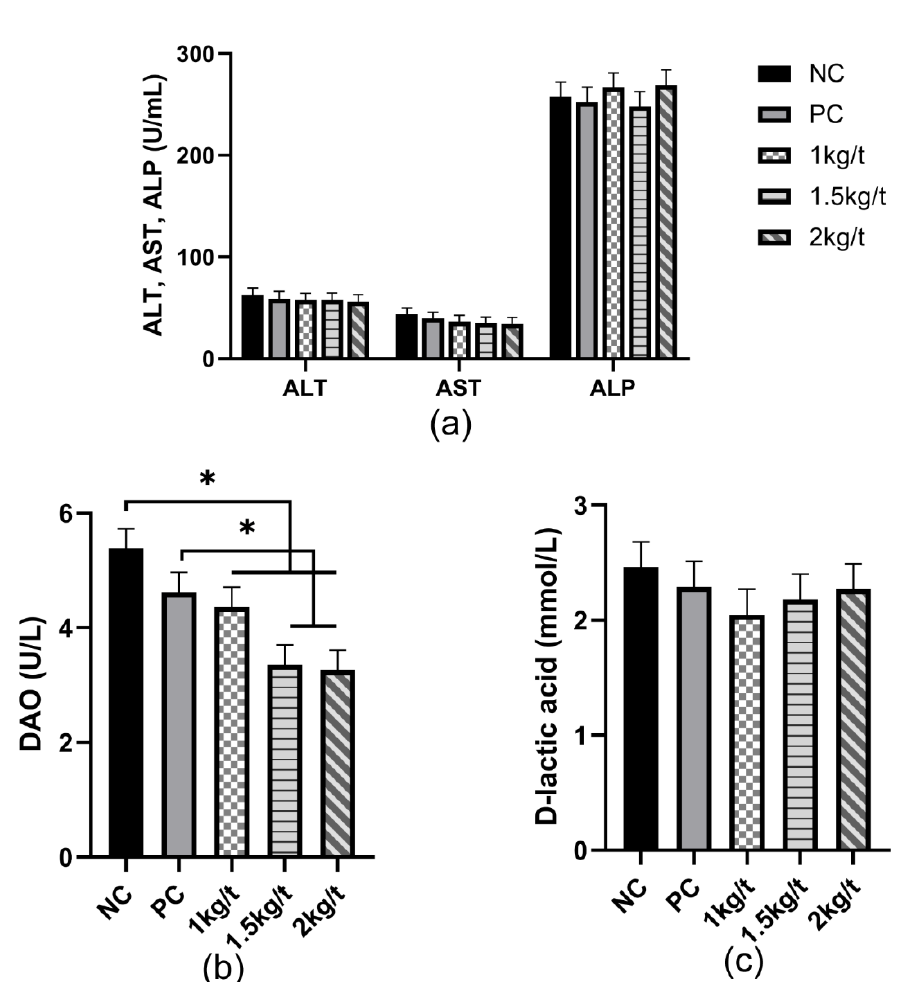
Figure 1. Effects of joint application of Lactobacillus plantarum and Bacillus subtilis on liver function and intestinal permeability in weaned piglets. ( a ) The amount of liver function-related indexes ALT, AST, and ALP in the serum of weaned piglets. ( b , c ) The amount of D-lactate and DAO, indicators related to intestinal permeability, in the serum of weaned piglets. “*” means there were statically significant differences ( p < 0.05). NC, a control diet; PC, NC + 150 ppm mucilage sulfate. Table 3. Effects of joint application of Lactobacillus plantarum and Bacillus subtilis on growth perfor- mance and diarrhea rate of weaned piglets. Mixture of